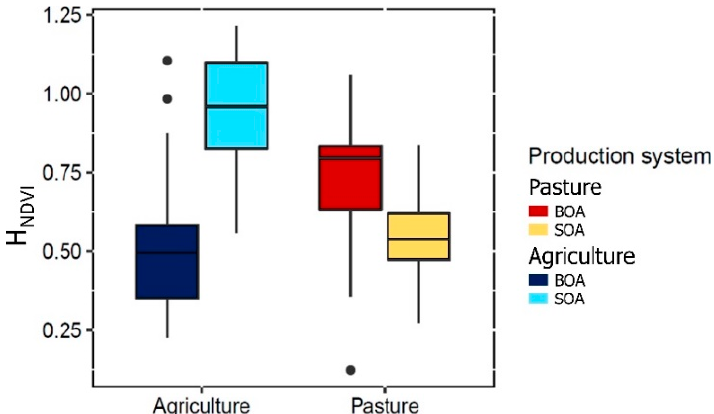
Figure 10. H NDVI boxplots for Katoyi agriculture and pasture LULC classes. (Orange) BOA systems; (Green) SOA systems.